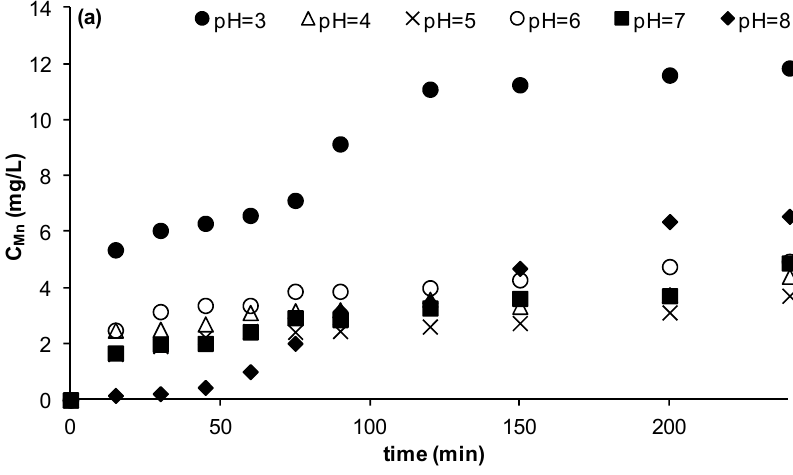
Figure 7. Mn leaching into solution ( a ) effect of pH; ( b ) effect of DO [ γ = 50 g, C = 23 mg/L, V = 50 mL, shaker speed = 150 rpm, T = 25.6 o C; ( a ) sand, m sand 0 solution DO = 8.95 mg/L; ( b ) pH =